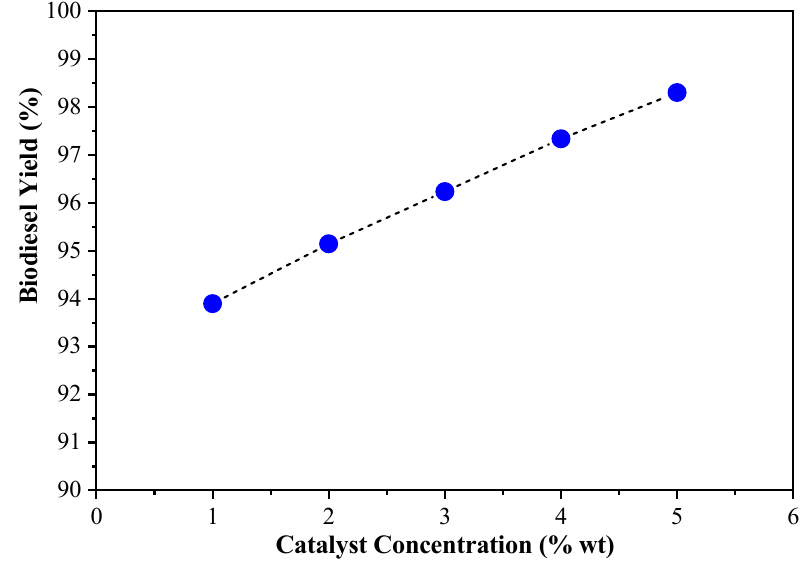
Figure 5. Effect of catalyst concentration on biodiesel yield.